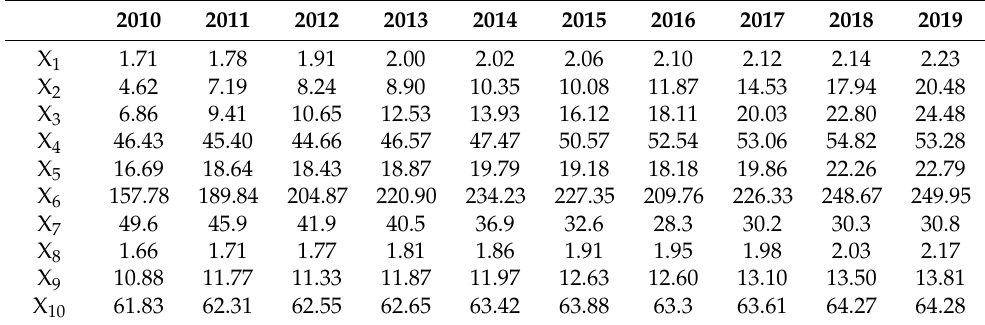
Table 4. Data of influencing factors of international competitiveness of China’s computer